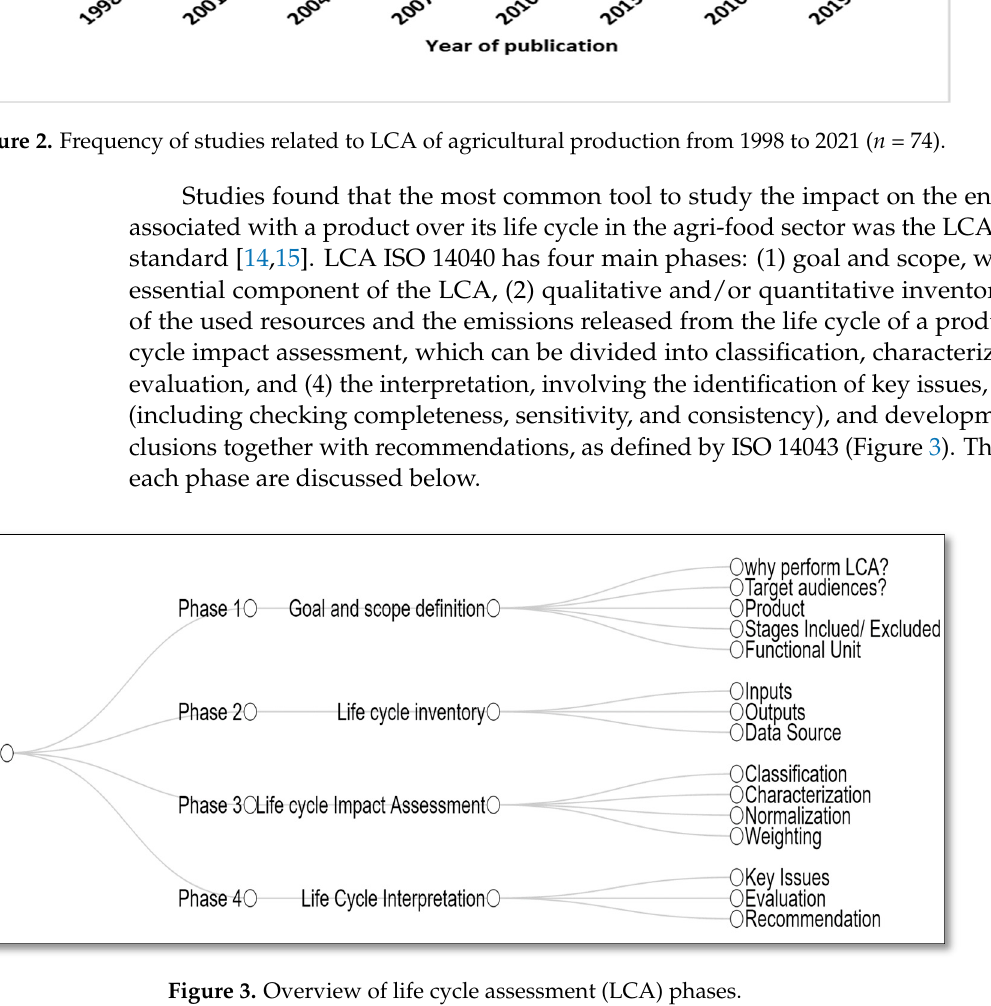
Figure 2. Frequency of studies related to LCA of agricultural production from 1998 to 2021 ( n = 74).